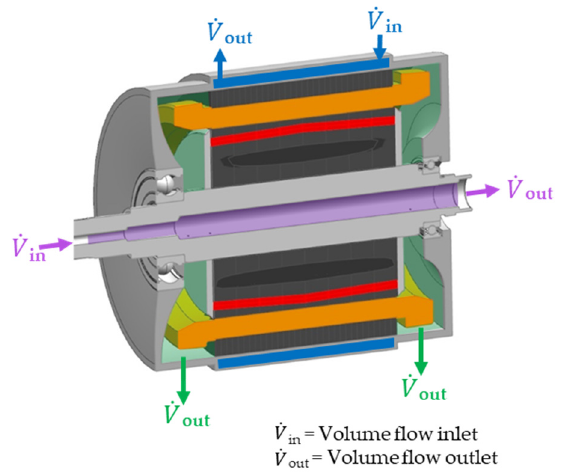
Figure 1. Illustration of shaft cooling, end winding cooling and stator jacket cooling in a permanent magnet synchronous machine (adopted from [5]).